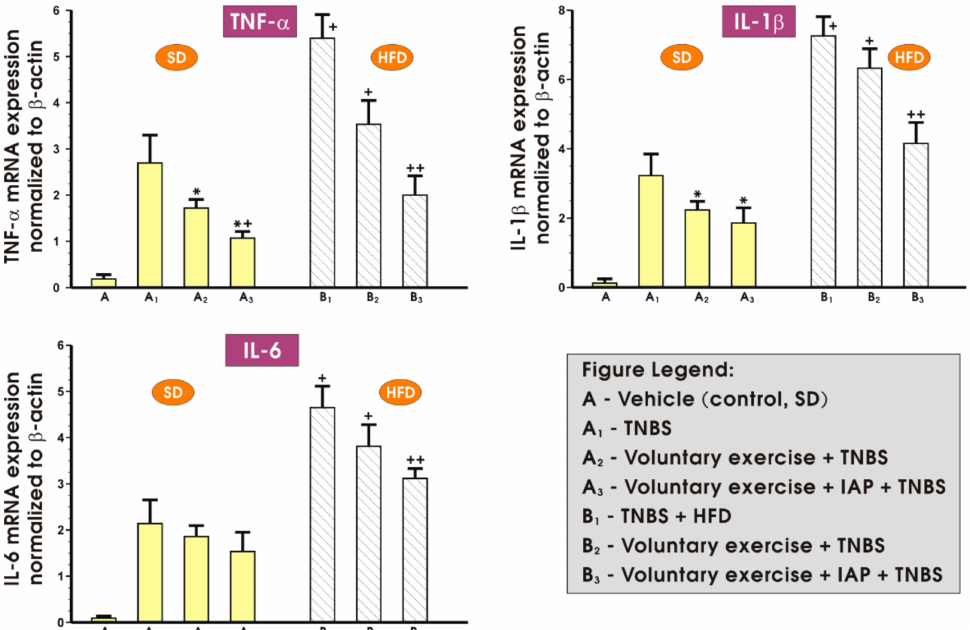
Figure 3. The effect of treatment with IAP combined with voluntary exercise on the mRNA expression of proinflammatory cytokines TNF α , IL-1 β and IL-6 in the colonic mucosa of sedentary or exercising mice fed an SD or a HFD. Results are mean ± S.E.M. of four animals per experimental group, * significantly different ( p < 0.05) from the sedentary colitis mice fed SD, * + significantly different from ( p < 0.05) the sedentary animals with colitis fed SD, + significantly different ( p < 0.05) from the sedentary colitis mice fed HFD without exercise, ++ significantly different ( p < 0.05) from the sedentary HFD animals with colitis subjected to voluntary